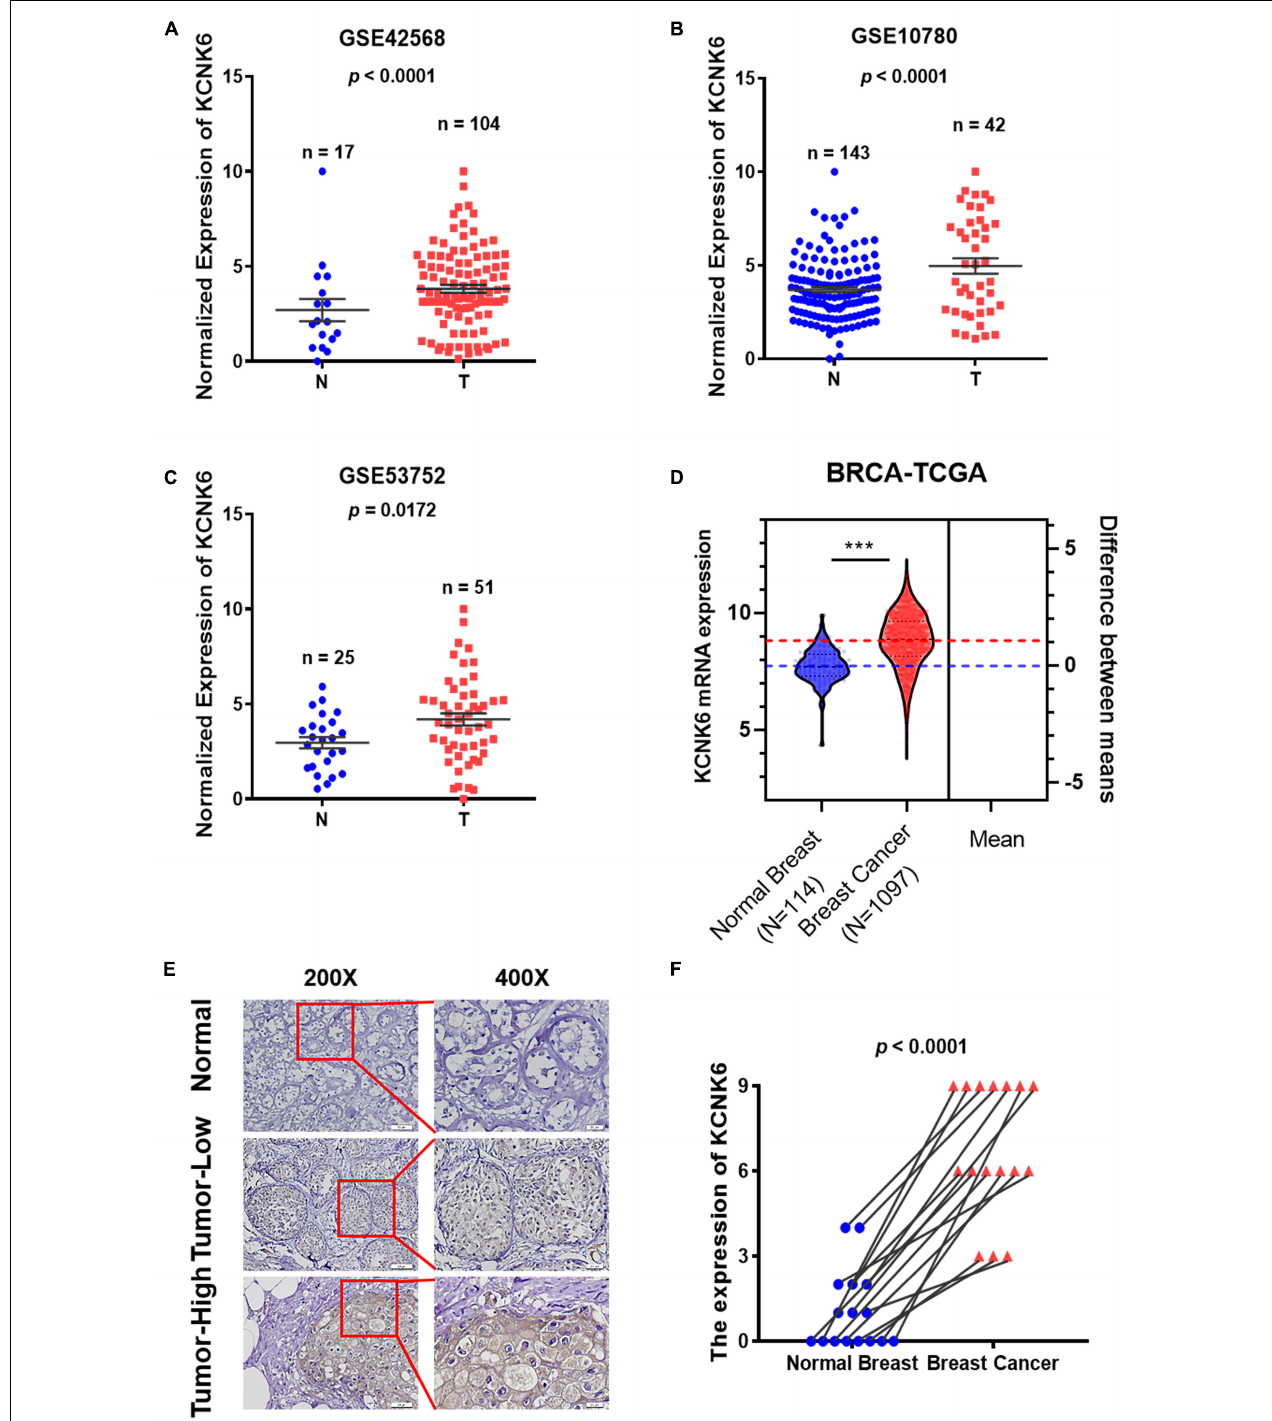
FIGURE 1 | Potassium channel protein KCNK6 expression was significantly increased in breast cancer. (A) KCNK6 expression was analyzed using the gene expression microarray data set GSE42568 from the Gene Expression Omnibus (GEO) database. Compared with normal breast tissue, KCNK6 expression in breast cancer tissue was significantly higher. N denotes normal, T, denotes tumor. (B) KCNK6 expression was analyzed using the gene expression microarray data set GSE10780 from the GEO database. Compared with normal breast tissue, KCNK6 expression in breast cancer tissue was significantly higher. (C) KCNK6 expression was analyzed using the gene expression microarray data set GSE53752 from the GEO database. Compared with normal breast tissue, KCNK6 expression in breast cancer tissue was significantly higher. (D) Using TCGA database to analyze the expression of KCNK6. (E) KCNK6 expression in normal breast tissue and breast cancer tissue. (F) KCNK6 expression in 16 pairs of normal breast tissues and breast cancer tissues. *** P < 0.001.